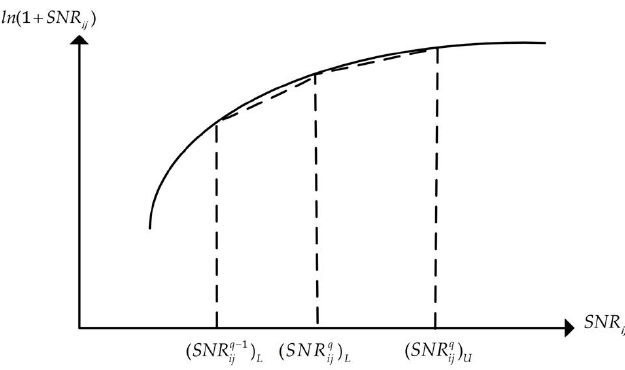
Figure 2. An illustration of linearizing the 𝑙𝑛 function in the 𝑞 th interval of 𝑆𝑁𝑅 𝑖𝑗 .